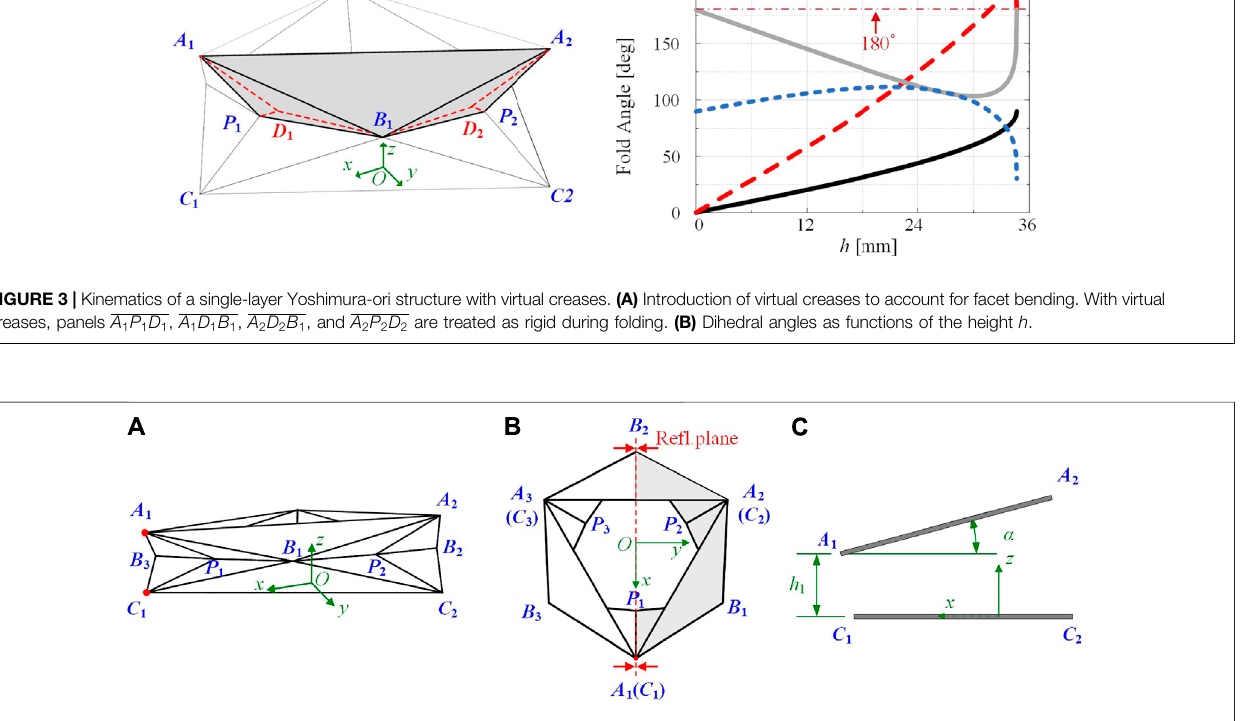
FIGURE 4 | Geometry of a single layer Yoshimura-ori structure in bending motion. (A) A single-layer Yoshimura-ori structure when the distance between the vertices A 1 and C 1 is reduced. (B) Top-down view of the structure, where the shaded area represents half of the structure to be studied, and the re fl ection plane is denoted. (C) Schematic illustration of the variable α and h 1 during bending motion.